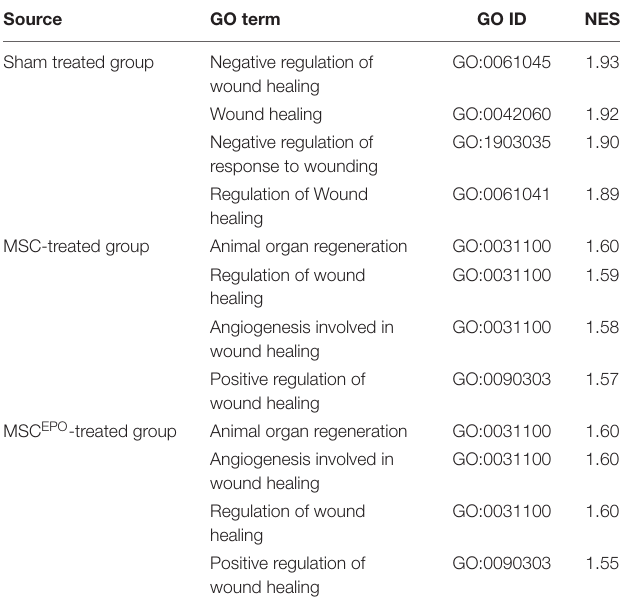
TABLE 2 | After performing a GSEA analysis, the nominal enrichment scores of the enriched gene sets in healing and regeneration were tabulated along with the respective GO IDs ( P adj < 0.05). NES, nominal enrichment score.